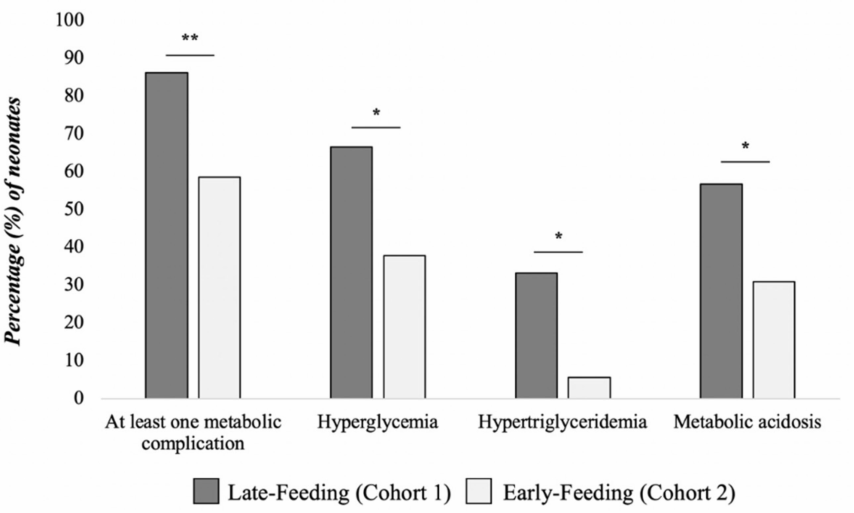
Figure 2. Rate of metabolic complications in the study sample. Notes. * p value < 0.05; ** p value < 0.01.